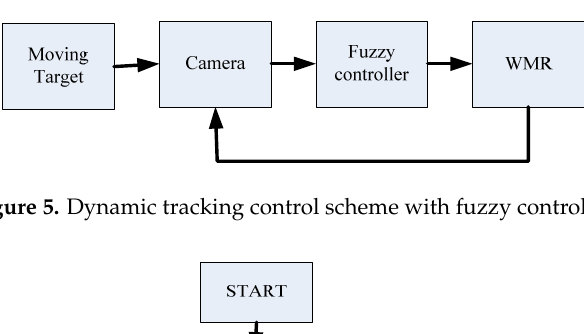
Figure 7. Membership functions of the horizontal position of a moving target in an image frame. 0